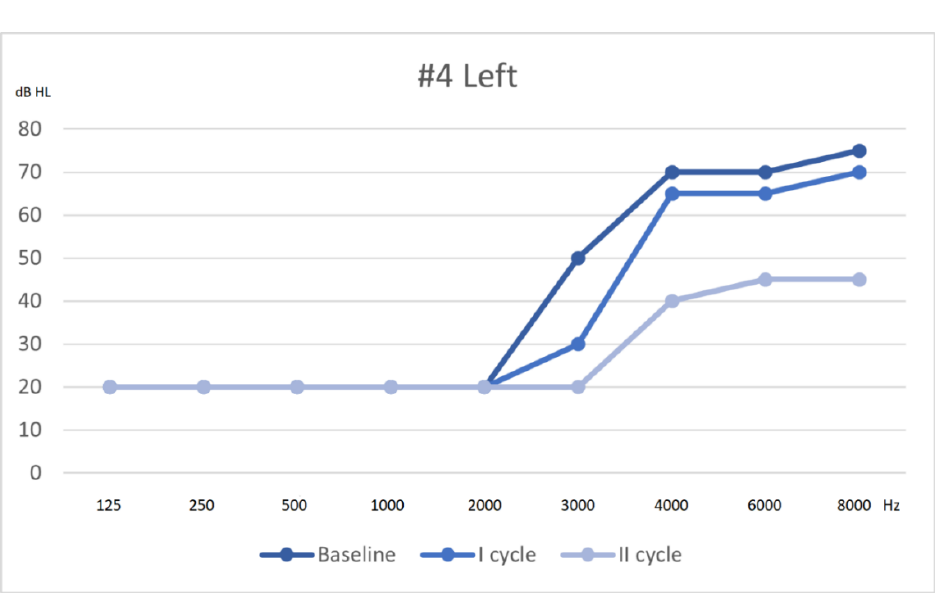
Figure 5. Hearing threshold of the right ear, from baseline to outcome (after 2 cycles of therapy). 3.5. Patient #5 Healthy 46-year-old woman, without history of disease, whose OP/NP swab tested positive for SARS-CoV-2 on 24 November 2020; three days later she felt asthenia, joint pain, fever and headache. She underwent a first cycle of drug therapy with azithromycin and prednisone. On 30 November, she complained about bilateral tinnitus and right ear fullness. Tinnitus (worse in the right ear), and fullness persisted during the treatment, while she recovered from other symptoms. A further OP/NP swab tested negative on 9 December. The same day she underwent a complete audiological assessment. PTA revealed moderate SNHL at 125-250-500 Hz (av- erage 50 dB HL) and mid frequencies (35 dB HL at 1000 Hz). Acufenometry showed a continuous right-sided 750 Hz 5 dB SL tinnitus; the THI scored 42 (grade 3). She did not complain about vertigo or dizziness; the DHI scored 0. The ABR was normal. The bedside vestibular and v-HIT examinations were normal.